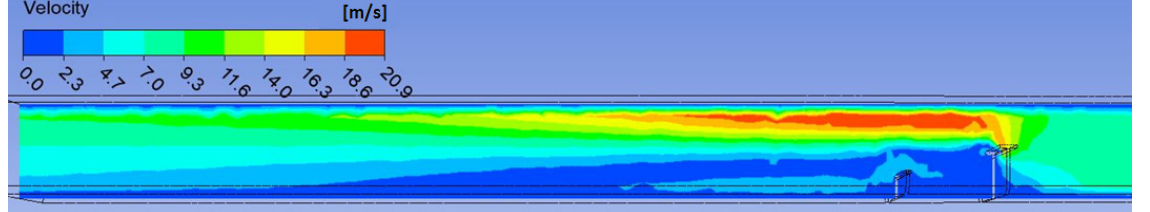
Figure 13. Streamlines; CFD model with a beam size of 288 mm with air deflectors upstream and downstream of the beam.